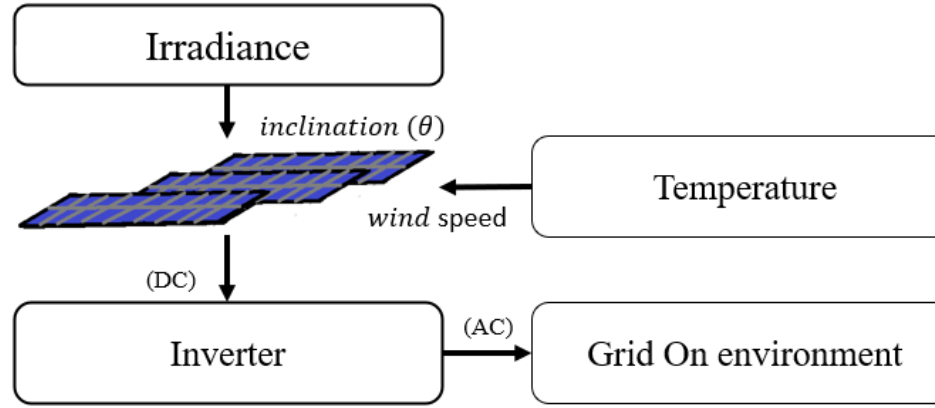
Figure 9. SPV Power Plant System Simple